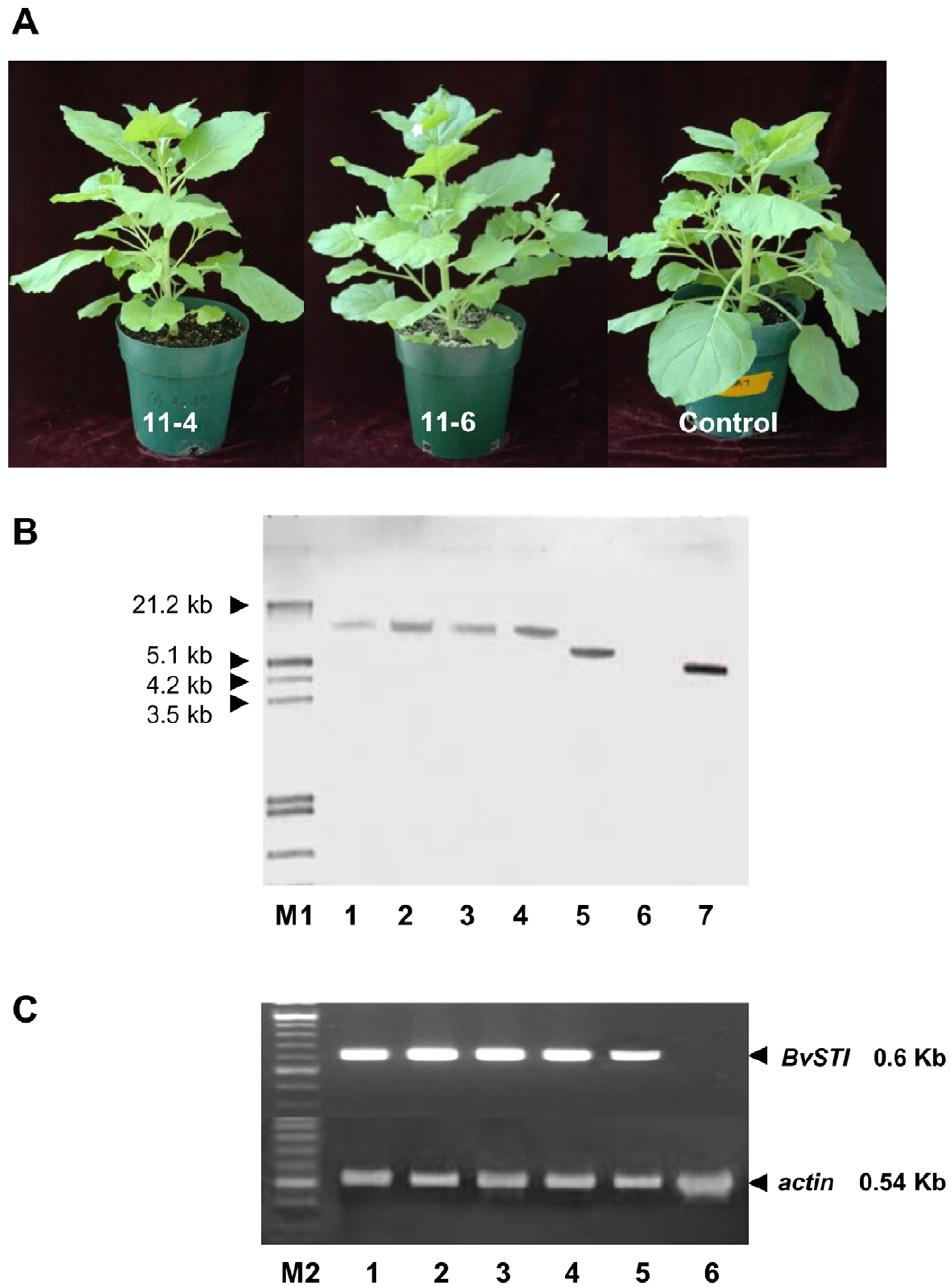
Figure 2. N.benthamiana plants transformed with the BvSTI gene. A) N. benthamiana 11-4 and 11-6 plants transformed with the BvSTI gene and normal untransformed plant . B) Southern blot of N. benthamiana plants. Lane 1–5, BvSTI transformant 11-4, 11-5, 11-6, 11-13 and 12-2, respectively; lane 6, untransformed normal control plant, lane 7, BvSTI plasmid DNA. All DNAs were digested with the NdeI restriction enzyme. M1, DNA molecular weight markers in kilobasepairs (Kb). C) RT-PCR analysis of transformants 11-4, 11-5, 11-6, 11-13 and 12-2 (lane 1–5, respectively) and normal untransformed control (lane 6) with BvSTI gene specific primers that amplify a 0.6 Kb gene fragment. Actin , housekeeping actin gene amplification with gene specific primers that generate a 0.54 Kb gene fragment (lane 1–6) used as quality and quantity control of the RNA being analyzed. M2, 100-bp DNA molecular weight markers.